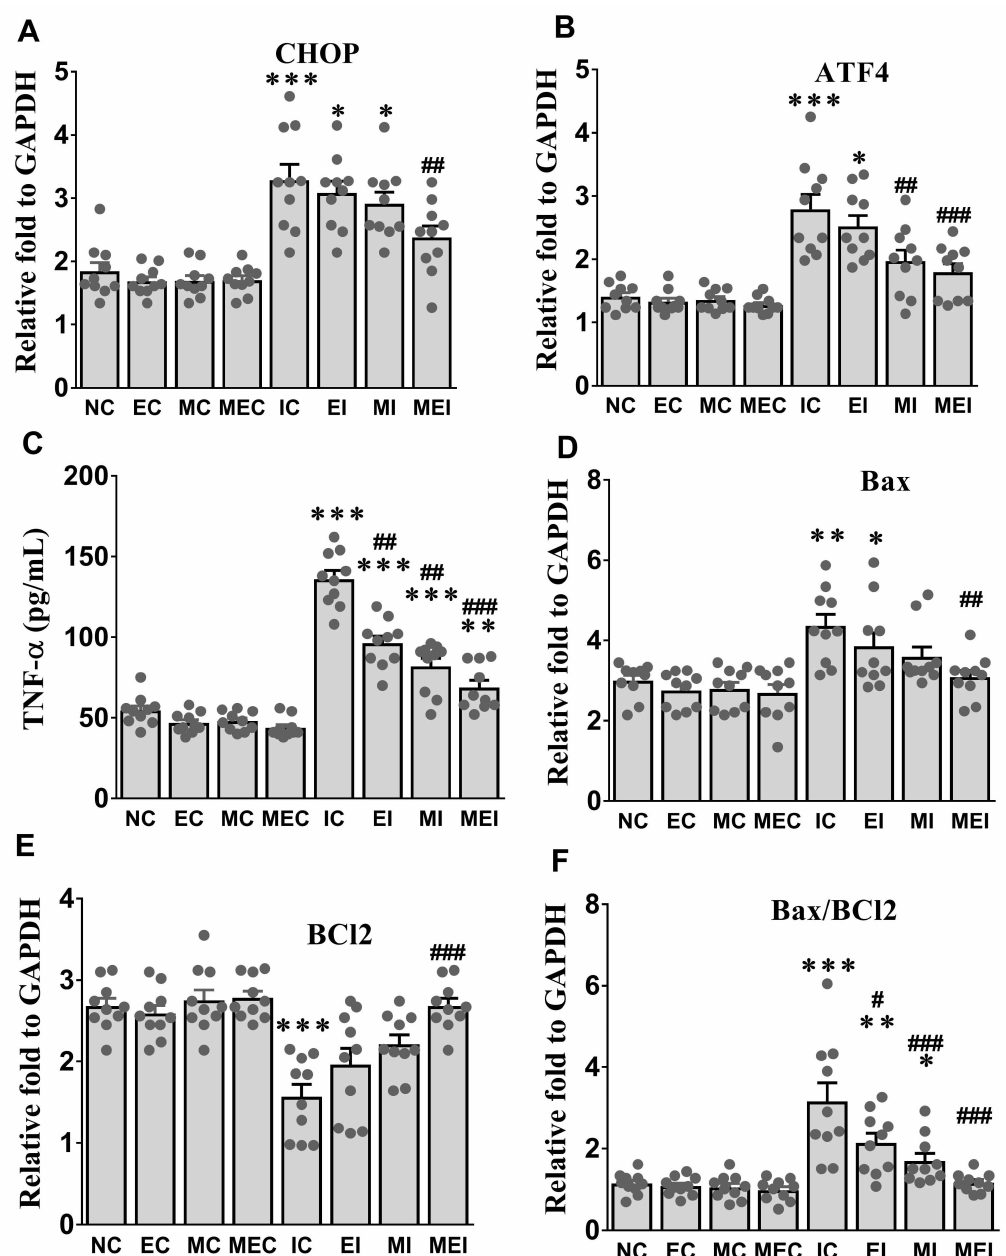
Figure 4. Effect of melatonin and exercise on cardiac ER stress, inflammatory cytokine, and apoptosis- related markers in isoproterenol-challenged rats. ( A ) CHOP, C/EBP homologous protein; ( B ) ATF4, Activating transcription factor 4; ( C ) TNF- α , Tumor necrosis factor alpha; ( D ) Bax, Bcl-2-associated X protein; ( E ) BCL-2, B-cell lymphoma protein 2; ( F ) Bax/BCL-2, the ratio of Bax and BCL-2. The data are reported as the mean ± SEM ( n = 6). * p < 0.05, ** p < 0.01, and *** p < 0.001 versus the NC group. # p < 0.05, ## p < 0.01, and ### p < 0.001 versus the IC group calculated through the Bonferroni post hoc test following one-way ANOVA. NC, normal control; EC, exercise control group; MC, melatonin control group; MEC, melatonin plus exercise control group; IC, isoproterenol control group; EI, exercise plus isoproterenol-challenged group; MI, melatonin plus isoproterenol-challenged group; MEI, melatonin and exercise plus isoproterenol-challenged